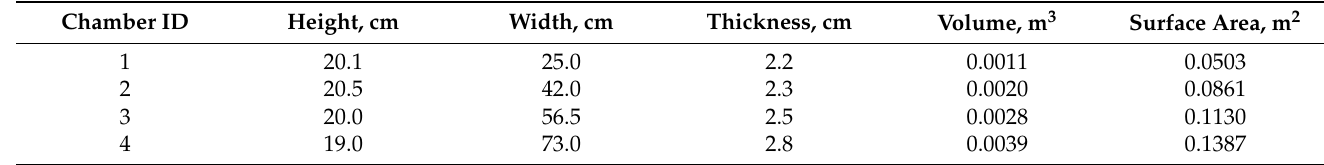
Table 3. Parameters of gas flux